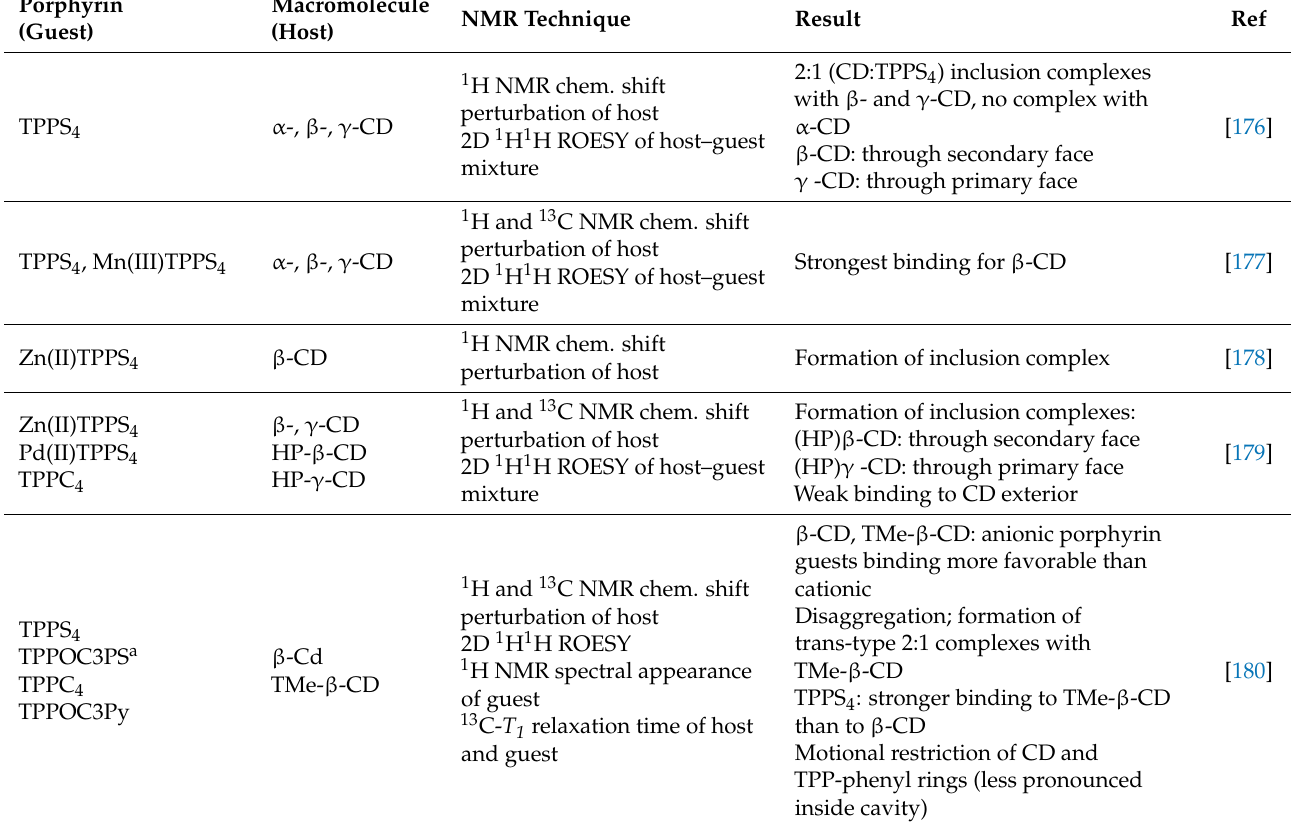
Table 3. Summary of NMR interaction studies between porphyrins and